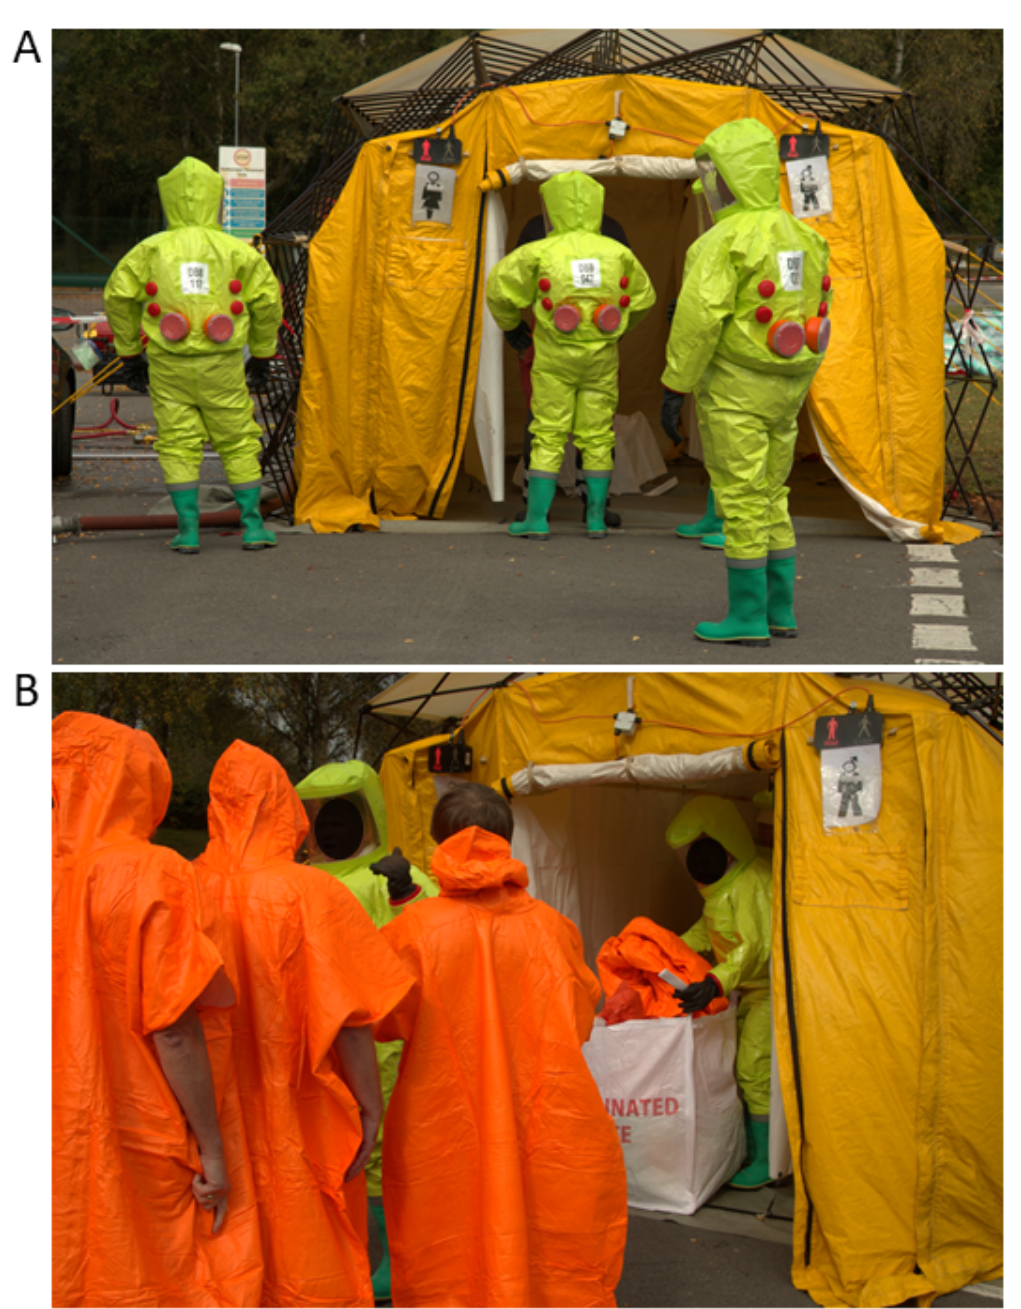
Figure 2. ( A ) A mobile mass decontamination unit (MDU) being set up by the emergency services during an exercise in the UK in 2019. ( B ) Disrobed casualties prepare to enter the MDU.